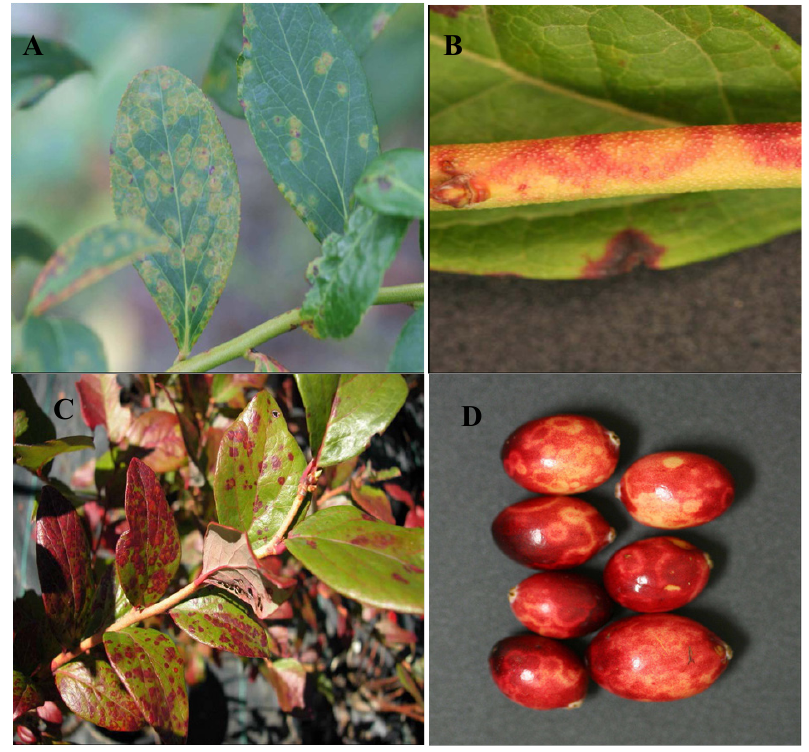
Figure 8. Symptoms of Blueberry red ringspot virus : ( A ) Early season leaf spots; ( B ) Red ringspots on young twigs; ( C ) Late season ring spots on leaves; and ( D ) Ringspots on cranberry